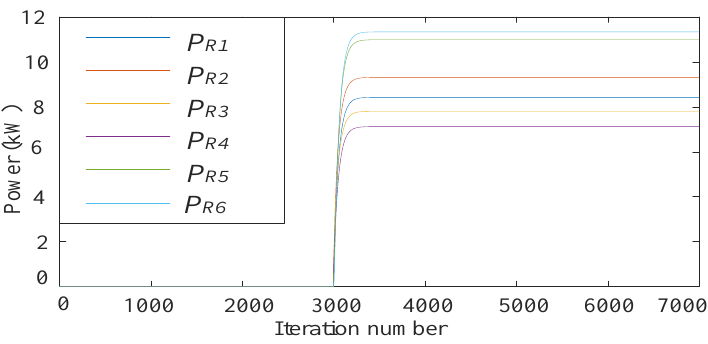
Figure 11. The power of each customer with ε = 0.001.